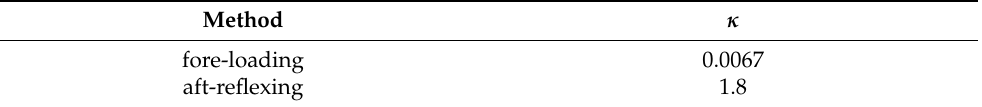
Table 6. The efficiency factor κ of fore-loading and aft-reflexing the kink airfoil.